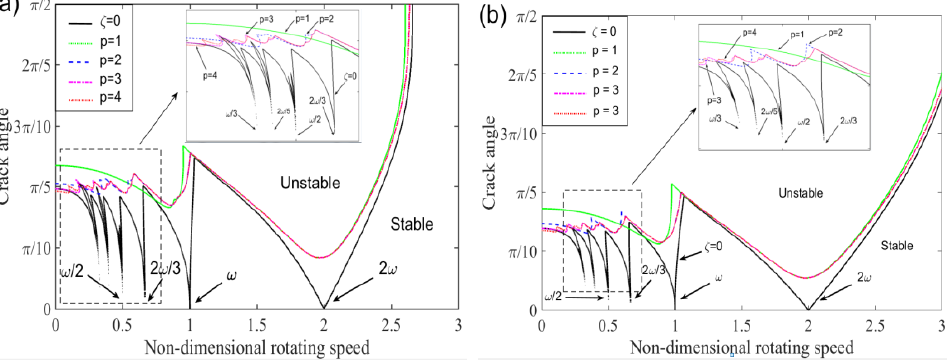
Figure 9. Stability regions. ( a ) without initial bending, ( b ) with initial bending.